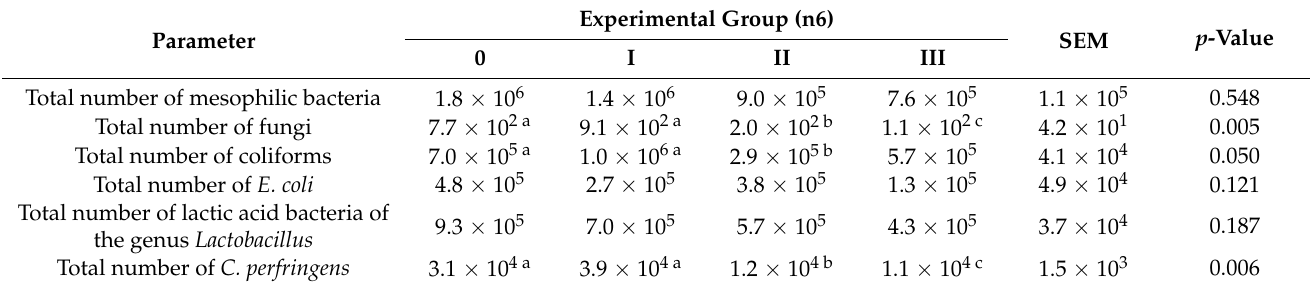
Table 4. The number of microorganisms in individual groups in the intestinal content of the animals (CFU/g).